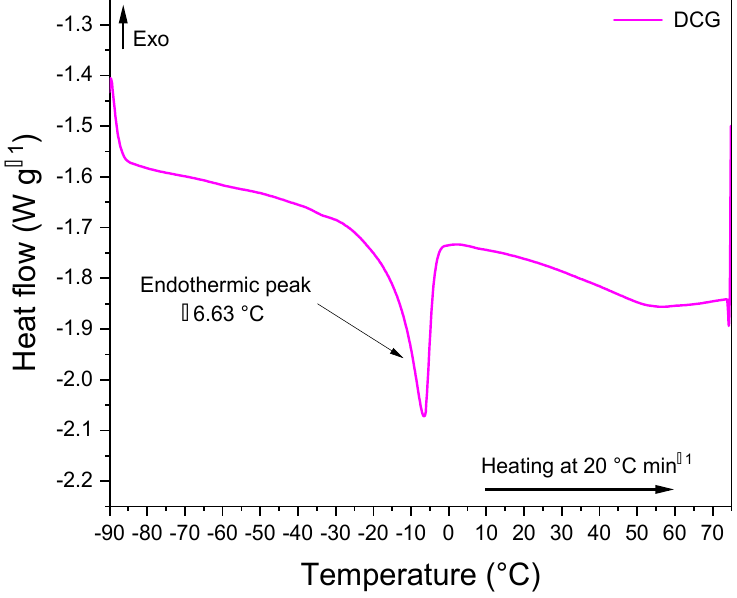
Figure 19. DSC thermogram of discarded chewing gum (DCG).